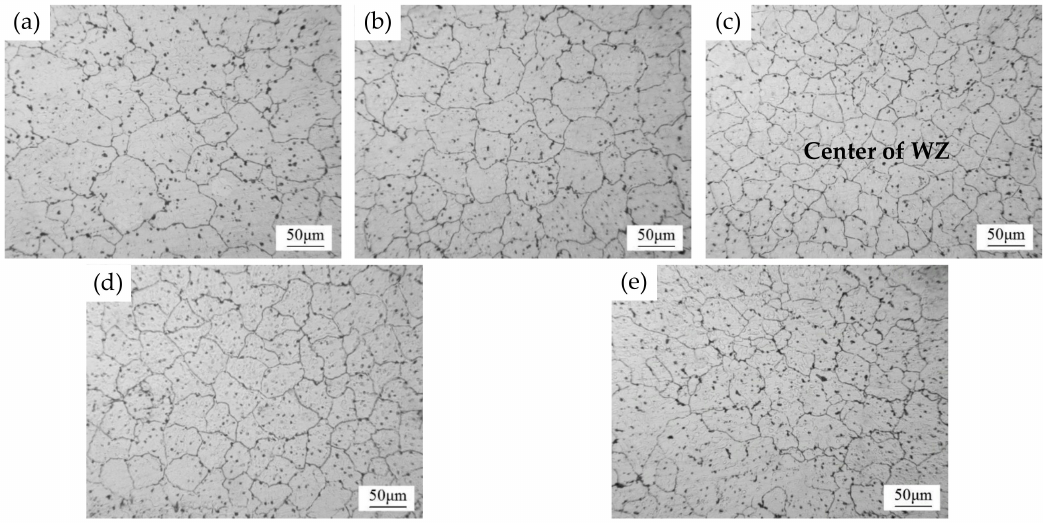
Figure 9. Optical microstructures of the weld center of welded joints at high magnification welded